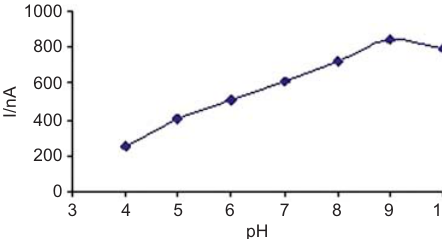
Figure 8 Effect of pH on the peak current of EZE.